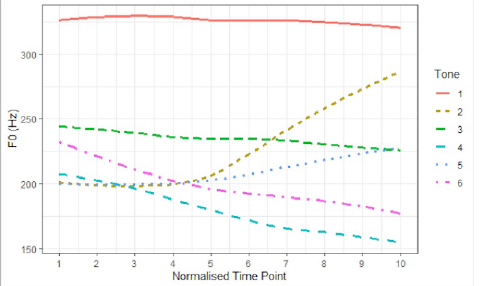
Fig 2. F0 curve of the six lexical tone stimuli across ten normalized time